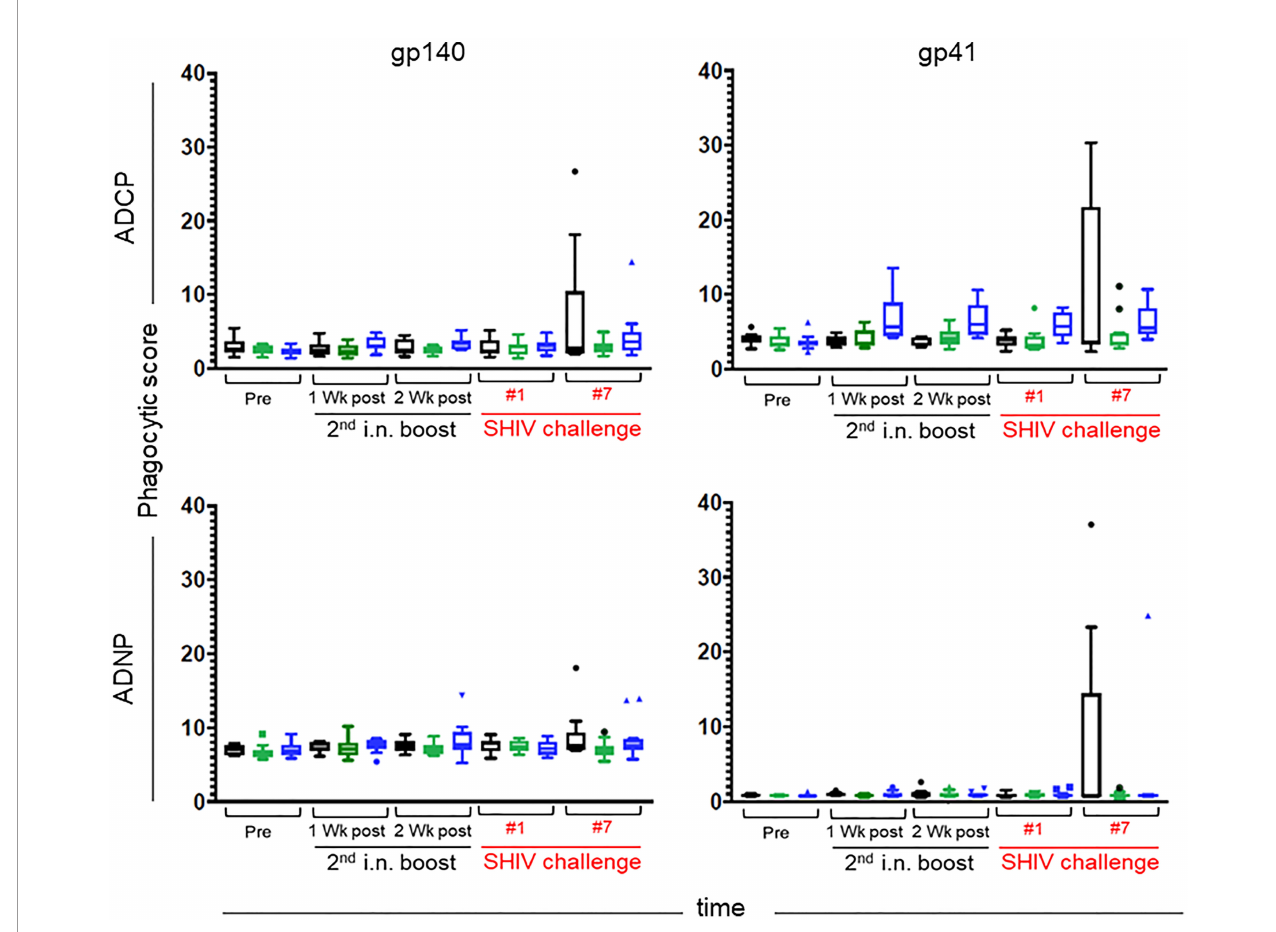
FIGURE 12 | Antibody-dependent Cellular Phagocytosis (ADCP) (top) and Antibody-dependent Neutrophil Phagocytosis (ADNP) (bottom) were assessed against gp140 SHIV SF162p3 (left) and the recombinant Mymetics rgp41 (right) antigens. Immunization groups are indicated in color; green, Group K; blue, Group L; black, Group M. Time points include pre-immunization (pre), one and two weeks after the 2 nd intranasal boost, the day of the 1 st SHIV challenge, and the day of the 7 th SHIV challenge (please see Figure 3 ). Phagocytic scores are reported for each assay; group medians are represented by the bar with Tukey ’ s box and